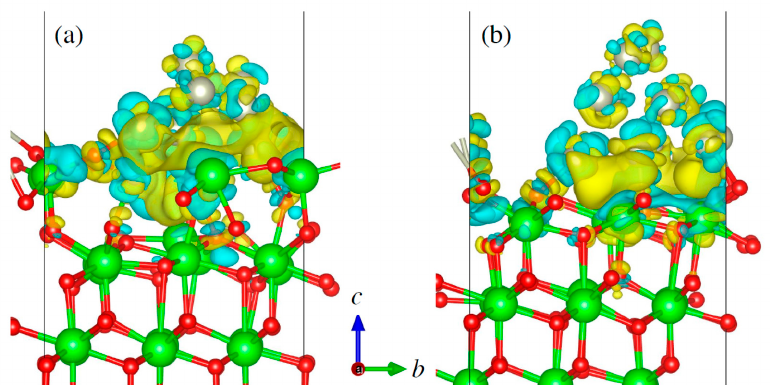
Figure 14. Side views of the electron density distributions in two systems: ( a ) a Rh 12 cluster embedded in a depressed Zr-terminated surface and ( b ) a Rh 12 cluster adsorbed on a flat oxygen-terminated surface. The positions of ions in ( a ) and ( b ) are the same as those in Figures 12b and 13b, respectively. The yellow-green isosurface represents positive Δρ = ρ (Rh 12 / support) − ρ (Rh 12 ) − ρ (support), and the sky blue isosurface represents negative Δρ . Δρ ~ 0 in the region where no isosurface is displayed.